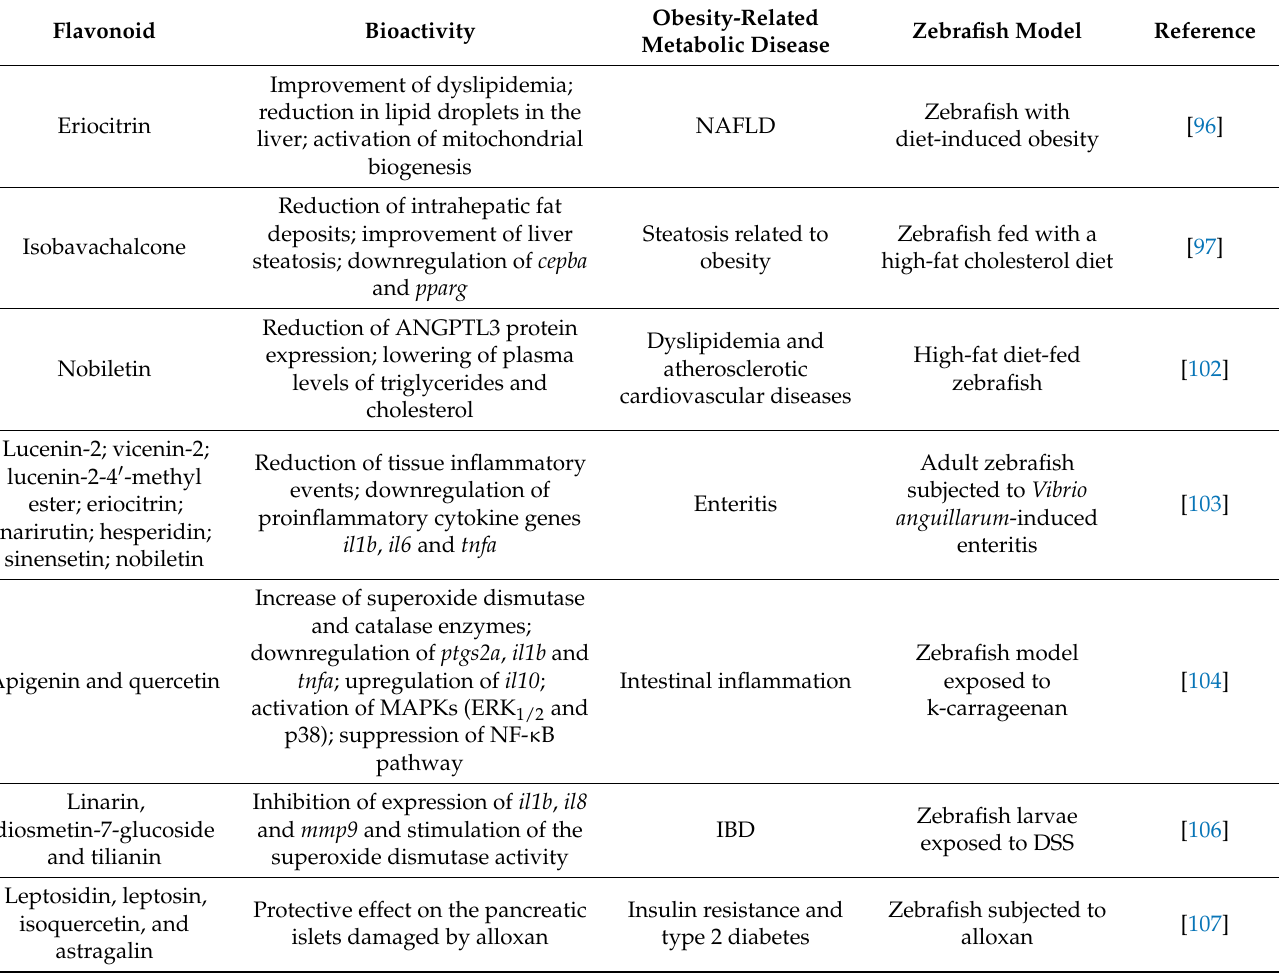
Table 3. Health-promoting effects of flavonoids against obesity-related metabolic diseases in